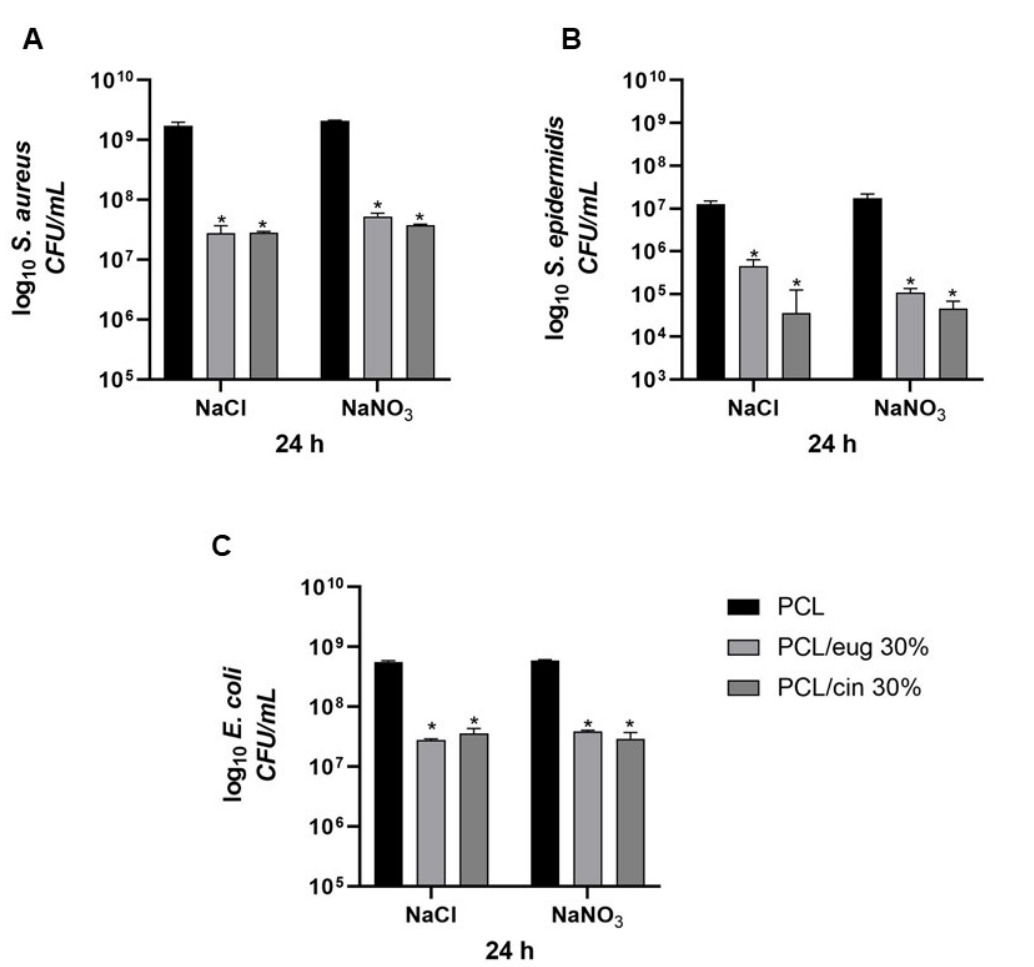
Figure 10. Number of adherent S. aureus ( A ), S. epidermidis ( B ) and E. coli ( C ) (log 10 colony forming unit, CFU/mL) on the PCL scaffolds added with 30% eugenol or cinnamon oil, produced with either NaCl or NaNO 3 salts, after 24 h of incubation. Results are the mean values ± standard error of the mean (SEM) of at least three independent experiments. * p < 0.001 vs. PCL, unpaired t -test. After 24 h of incubation, the quantification of planktonic bacteria was conducted, and the results are presented in Figure 11: a similar significant ( p < 0.05 or p < 0.001) reduction in planktonic bacteria was recorded, with a count decrease depending on the tested